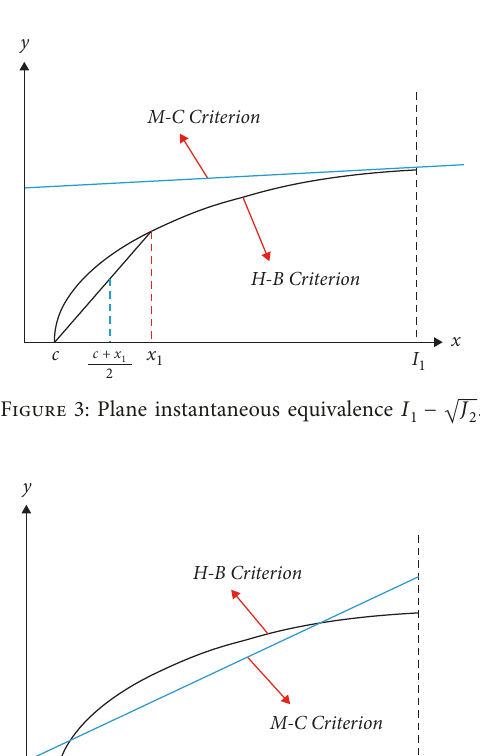
Figure 4: Optimal approximation of the graph plane I